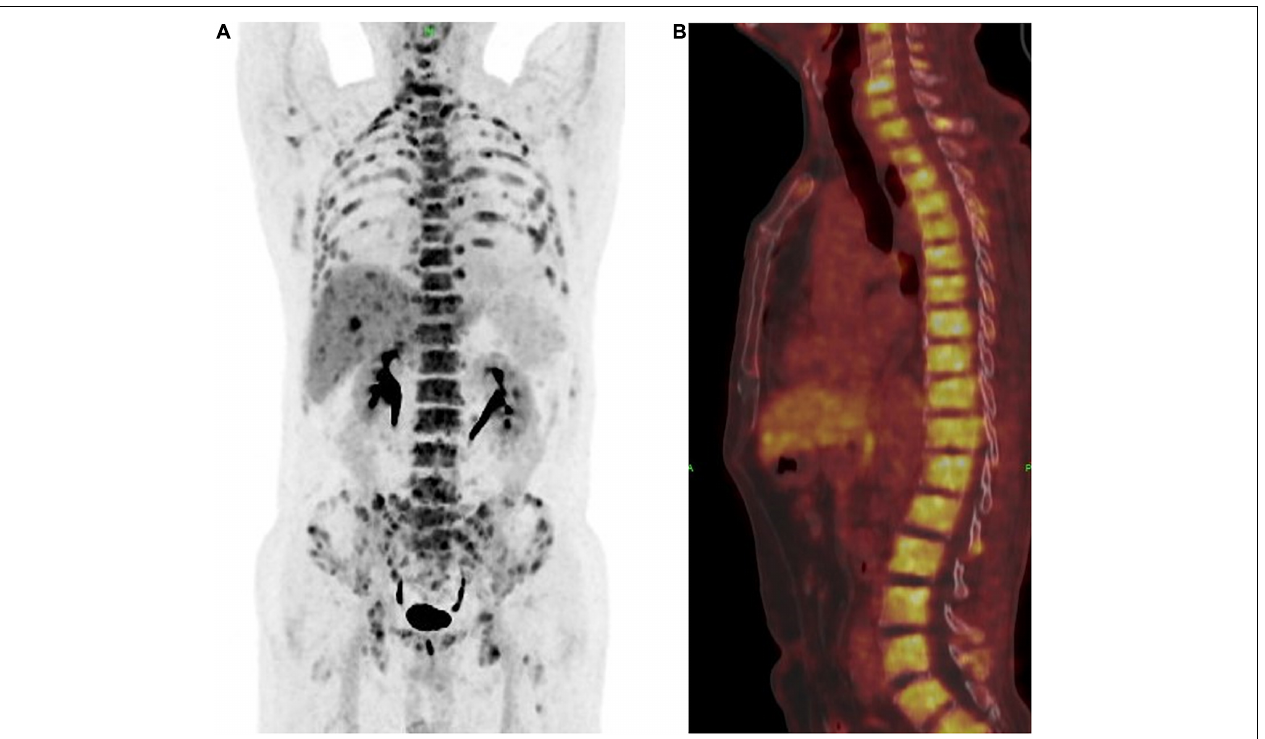
FIGURE 1 | (A) Positron emission tomography and computed tomography (PET-CT) showed a multiple bone destruction with bone metastases including whole vertebra, occipital bone, ribs of double side, appendicular skeleton, and pelvis. (B) PET-CT showed a whole vertebra metastatic Primary EMPD, showing that a most